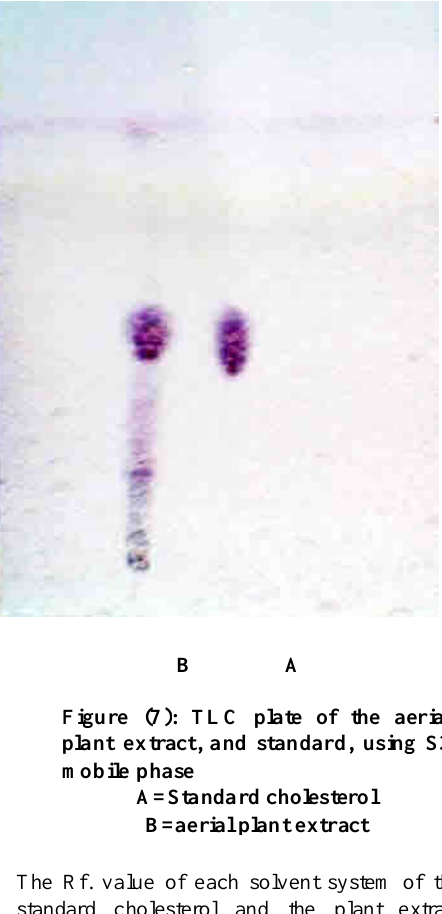
Figure (5): TLC plate of the aerial plant extract, and standard, using S1 mobile